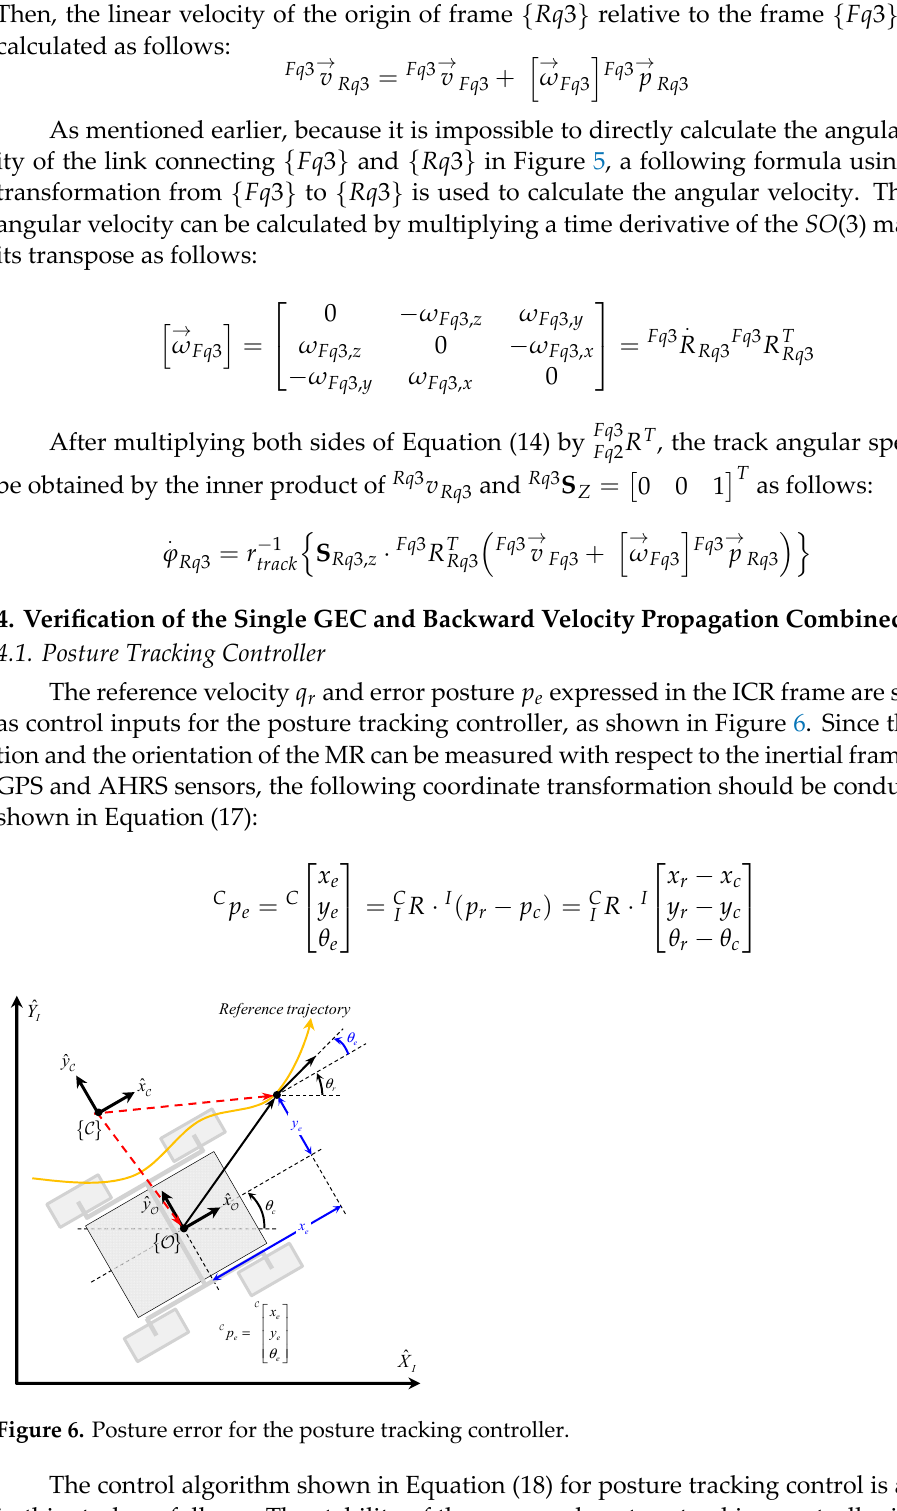
Figure 7. Overall simulation framework to verify the performance of the (1) TTCA-based driving velocity projection method and (2) velocity propagation driving velocity projection method based on the RecurDyn-Simulink co-simulator. Table 2. Mechanical dimensions of 3D model of PASTRo for proposed simulation. Symbol